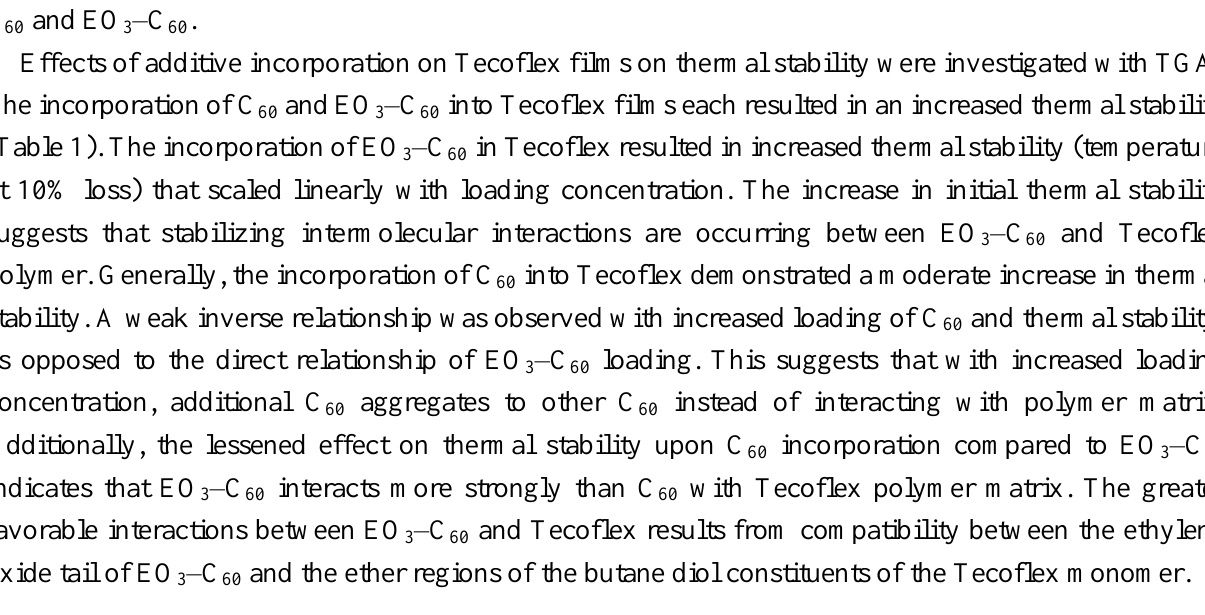
Table 1. Thermal properties of Tecoflex